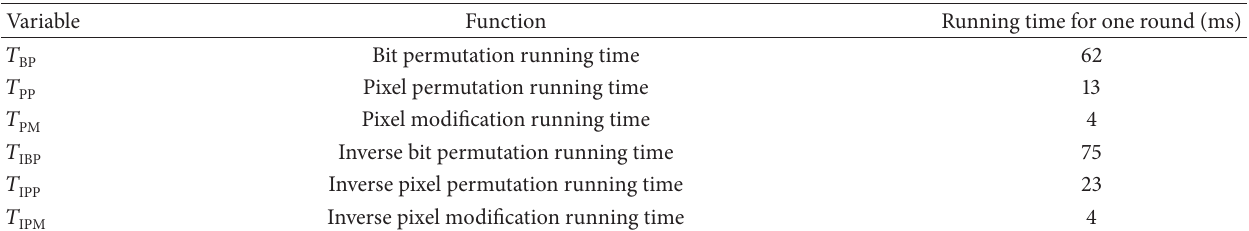
Figure 4: Decryption model architecture. Table 2: Evaluated running time for main functions in proposed cryptosystem.